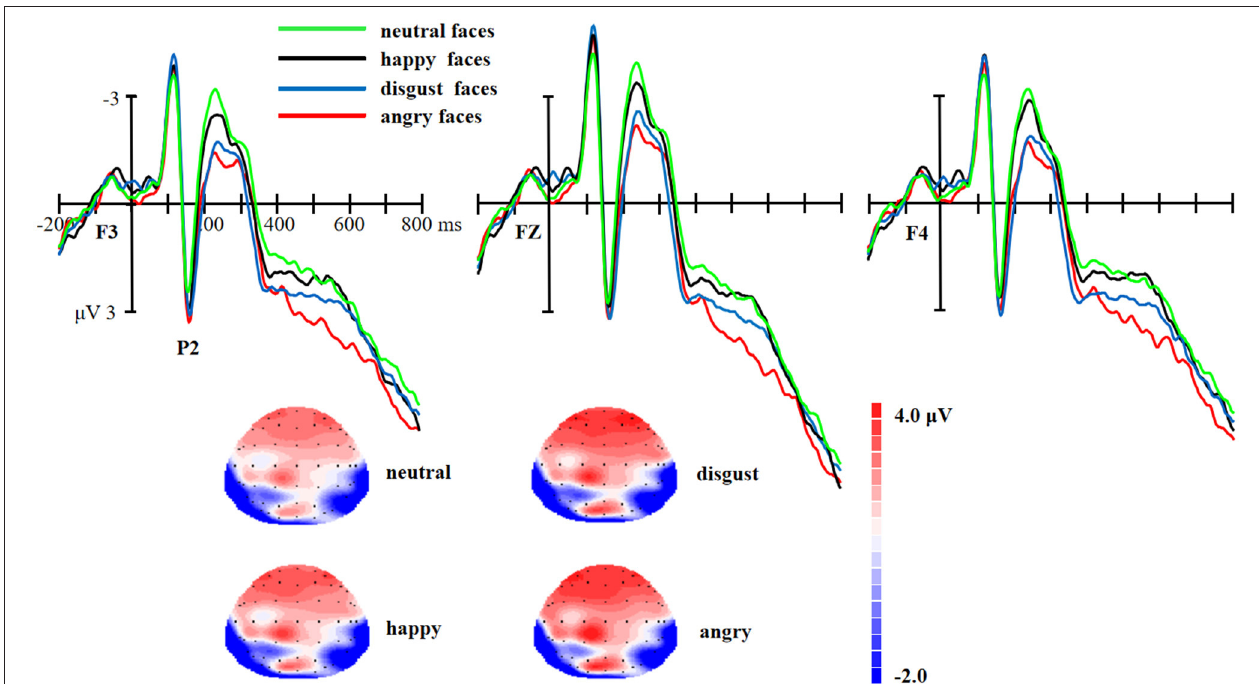
FIGURE 3 | Upper: The ERP waveforms for angry, disgust, happy, and neutral facial expressions at F3, FZ, and F4 electrode sites. Bottom: The scalp distribution of the P2 (145–175ms) for angry, disgust, happy, and neutral facial expressions.